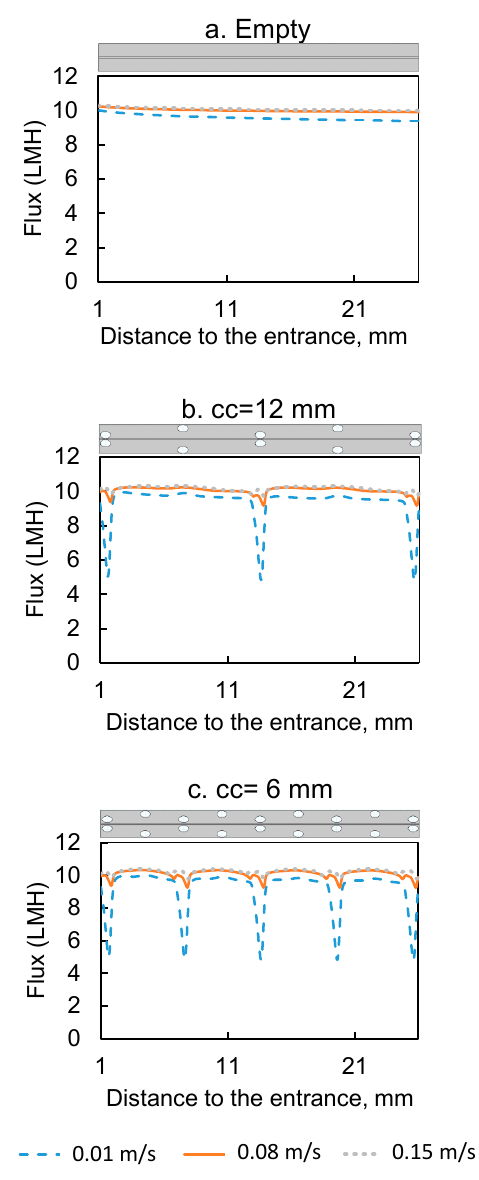
Figure 5. Water fluxes under different velocities along the membrane surface from the empty flow channel and the spacer-filled flow channels with center-to-center filament distances of 6 mm and 12 mm and 0.01 mm distance between the filaments and membrane. The first and last 1 mm of the channel were excluded to remove entrance and exit effects. The sketch of the part of the channel whose data are presented is placed on top of the corresponding plot to illustrate the location of the spacer inside the flow channel.